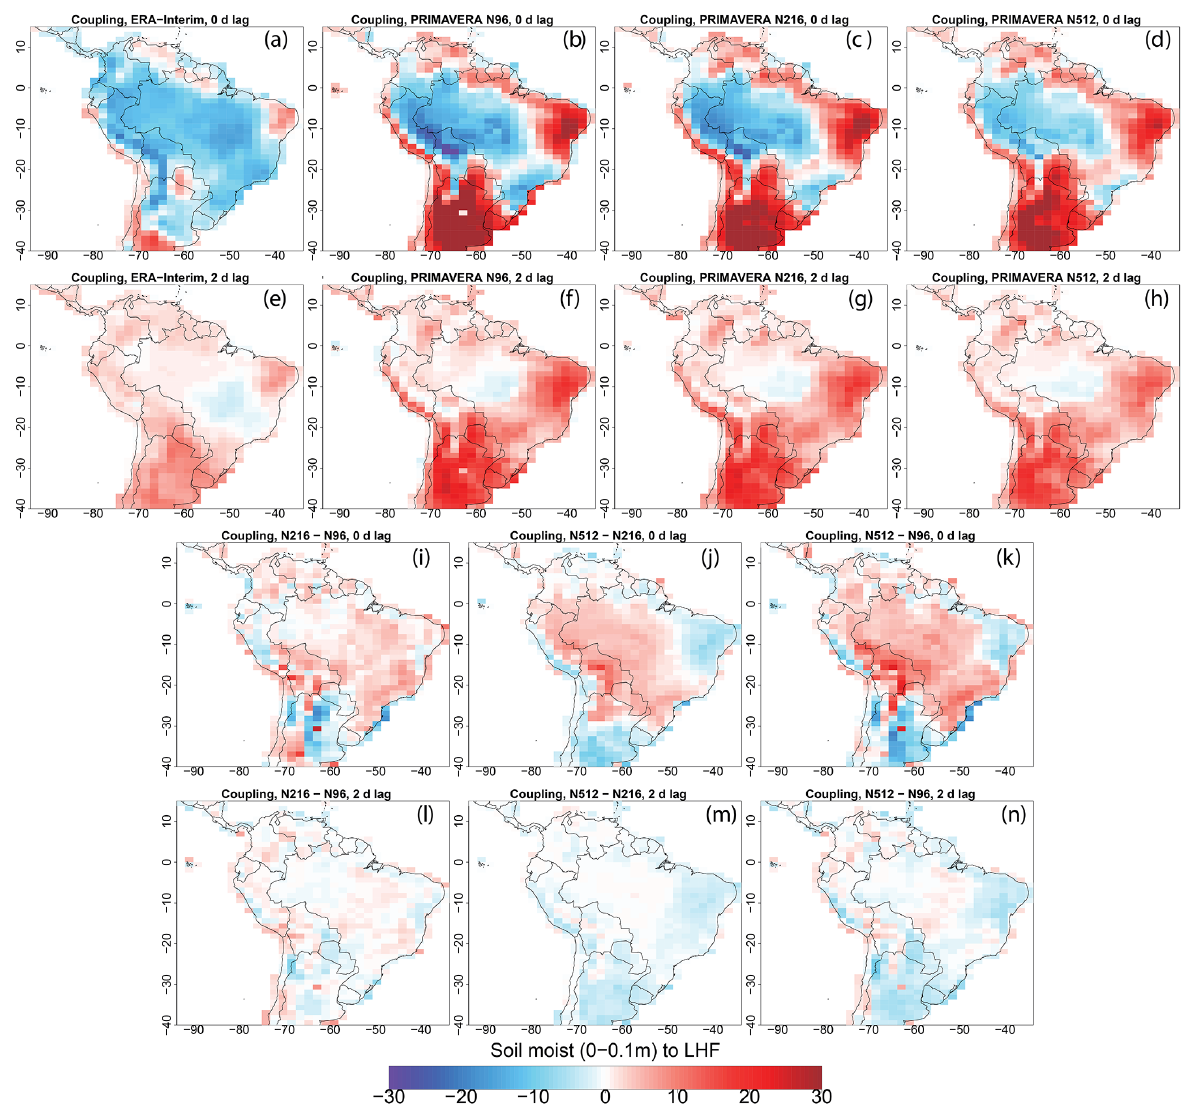
Figure 8. As in Fig. 7 but for the coupling strength between daily soil moisture (in the top 0.1m of soil) and latent heat flux